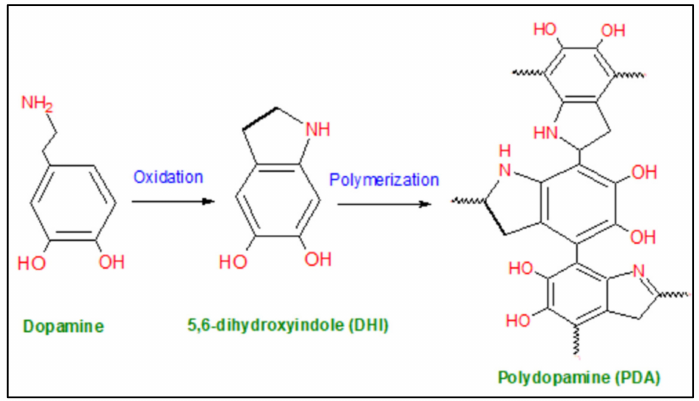
Figure 1. Polydopamine (PDA)